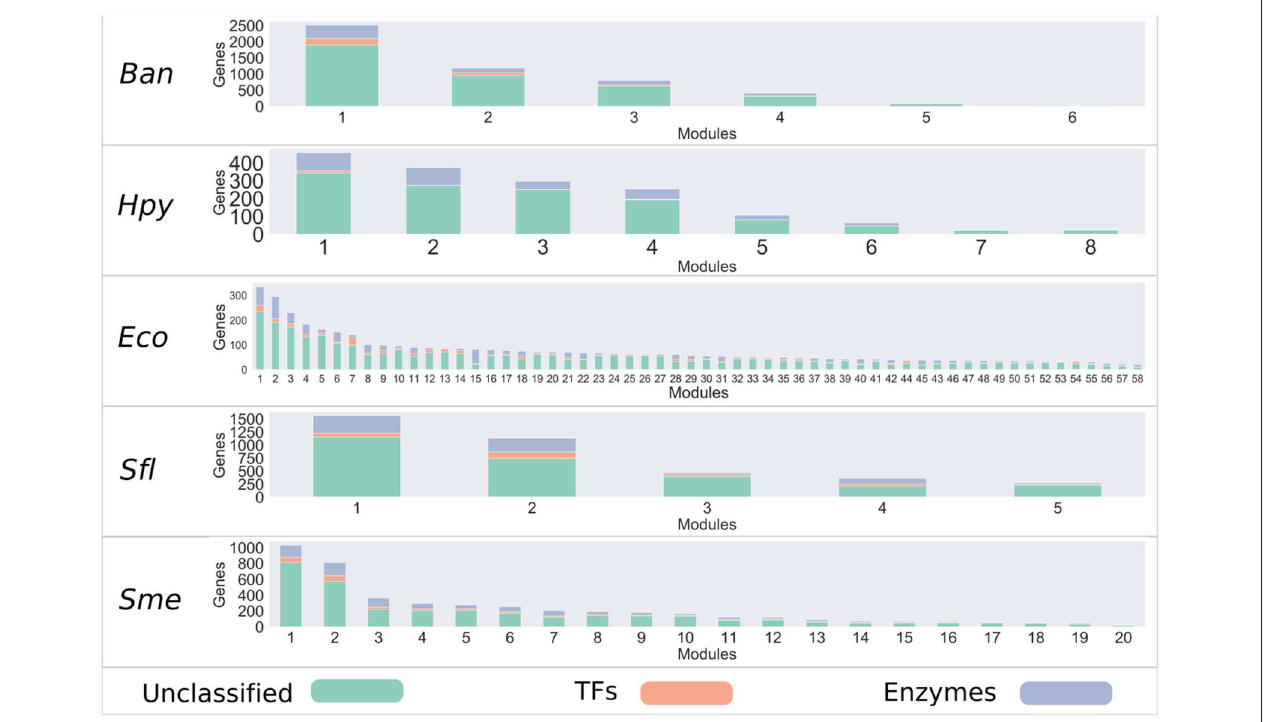
FIGURE 1 | Bacteria co-expression modules. On the x-axis are shown the modules identified with the WGCNA package, identified with a number. The distribution of modules is represented in decreasing order, where the y-axis represents the number of genes per module. Each module is made up of a set of genes associated with TFs (orange), metabolic enzymes (blue), and unclassified genes (green).